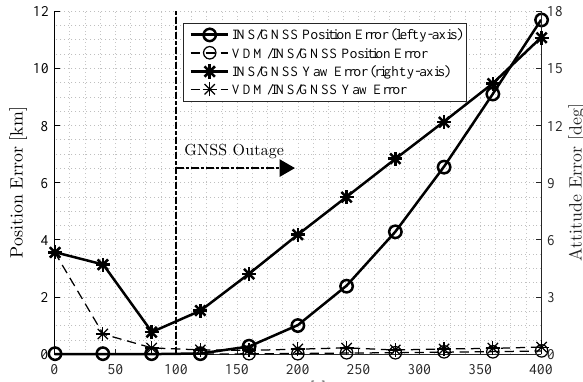
Figure 4: Comparison between INS/GNSS and VDM/INS/GNSS: RMS of position and yaw errors from 100 Monte Carlo